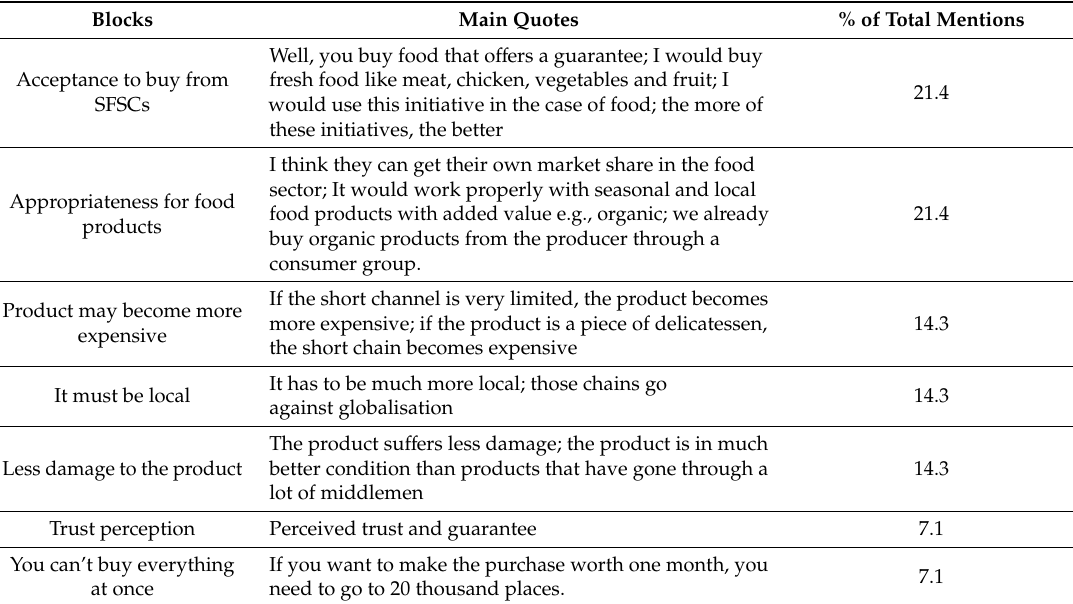
Table 2. Consumers’ comments on the use of physical short supply